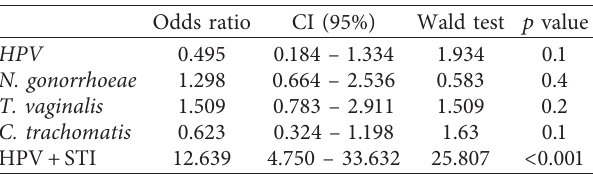
HPV: Human papillomavirus ; STI: sexually transmitted infection; data were analyzed through multiple linear regression, using one-way ANOVA to verify statistical significance ( p < 0 . 05).